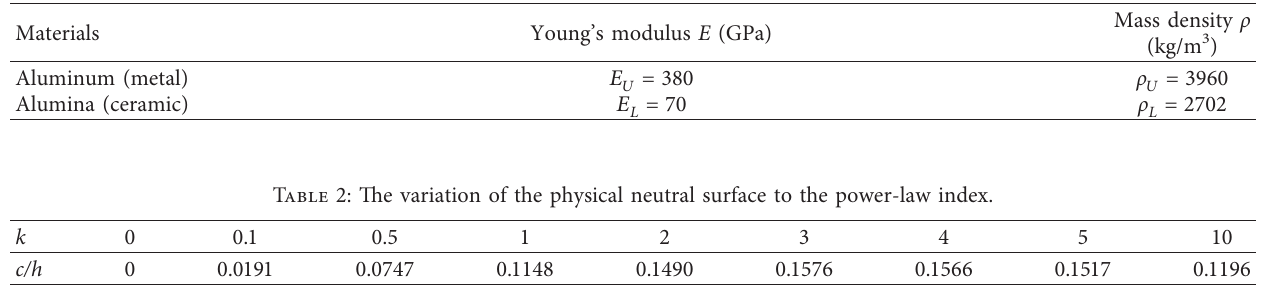
Table 1: The material properties of aluminum and alumina [50].